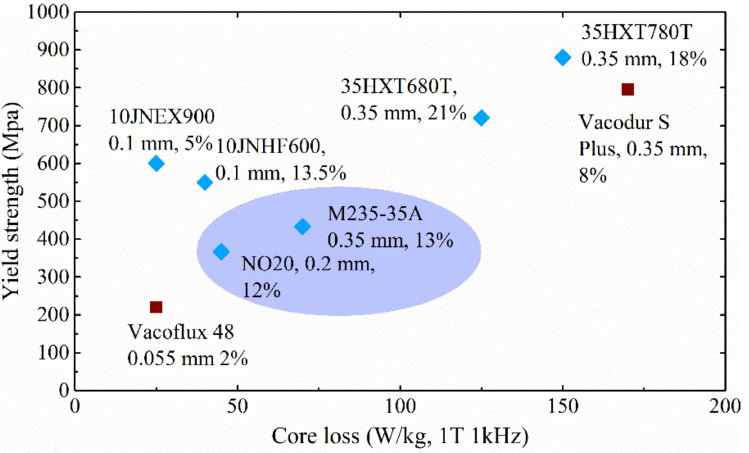
Figure 3. Conventional high-spec and new electrical